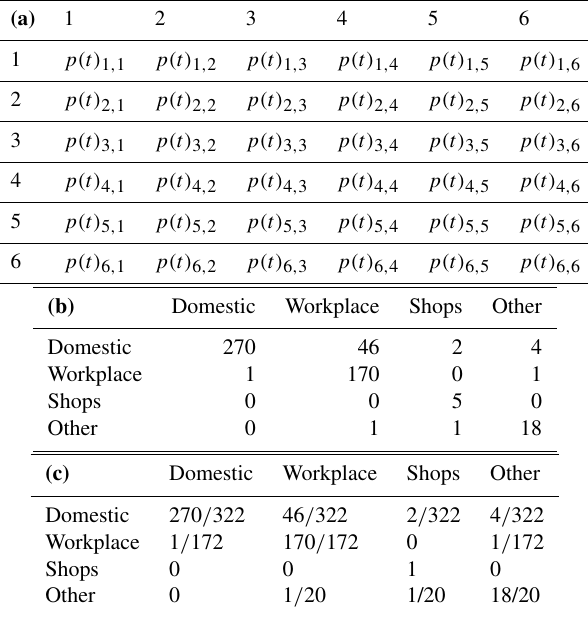
Table A1. Markov transition matrix (a) general for six states (rows and columns), (b) example data for adult O C at a single time step (Gershuny and Sullivan, 2017), and (c) transition probabilities for the data in (b)